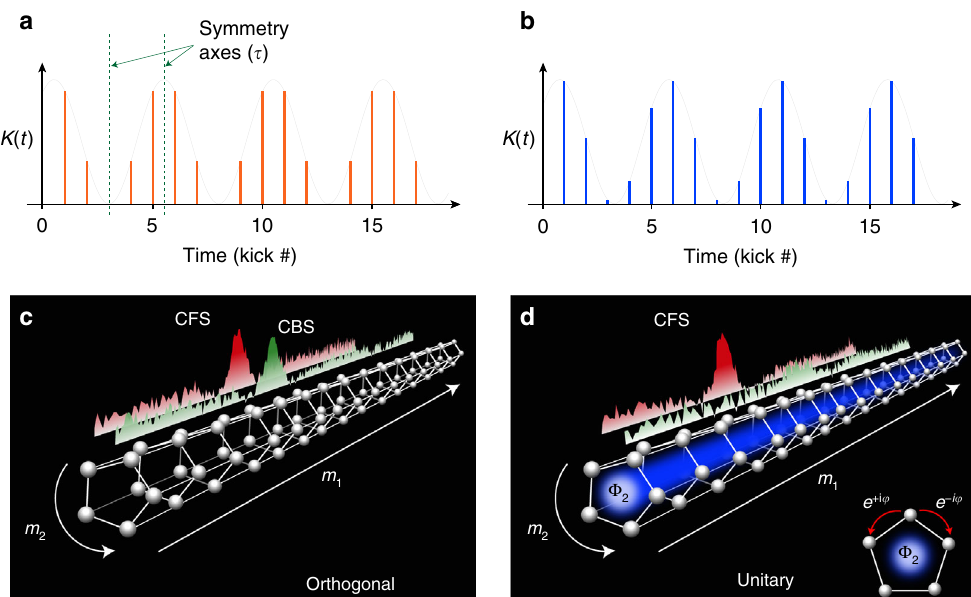
Fig. 1 Arti fi cial gauge fi elds engineering via periodically modulated driving. By tailoring the temporal dependence of the driving parameters — either the amplitude Kð t Þ or the phase a ( t ) — we are able to create an arti fi cial gauge fi eld which controls the time-reversal symmetry properties of a periodically driven (Floquet) system. For example, for a time-symmetric kick sequence a the system belongs to the orthogonal symmetry class, whereas a kick sequence without any particular symmetry axes b puts the system in the unitary symmetry class (broken T -symmetry). c , d Our kicked-rotor system with periodic amplitude (or phase) modulations (1) maps on a disordered synthetic nanotube in momentum space threaded by an arti fi cial Aharonov – Bohm fl ux Φ fl ux is zero, whereas a non-symmetric sequence b corresponds to the presence of a non-zero Aharonov – Bohm fl ux 2 . For the symmetric sequence a this Φ 2 (sketched as the light blue area). Experimentally, two distinct interference signatures can be used to characterize symmetry and localization: the disappearance of the CBS peak is a clear-cut signature of the symmetry breaking, while the emergence of a CFS peak is a direct interference signature of the onset of Anderson localization, in both symmetry